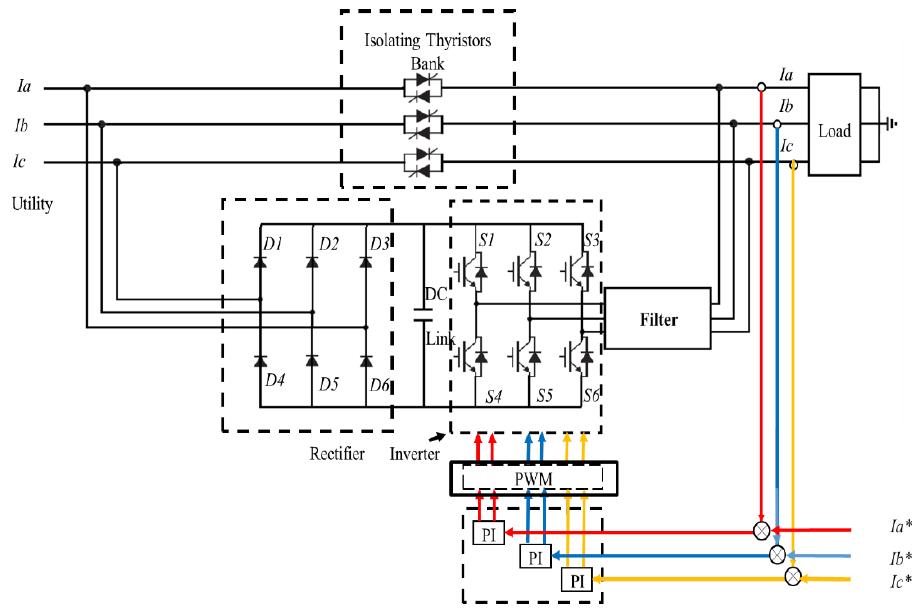
Figure 3. Complete diagram of the proposed asymmetrical fault correction technique for a sensitive load.